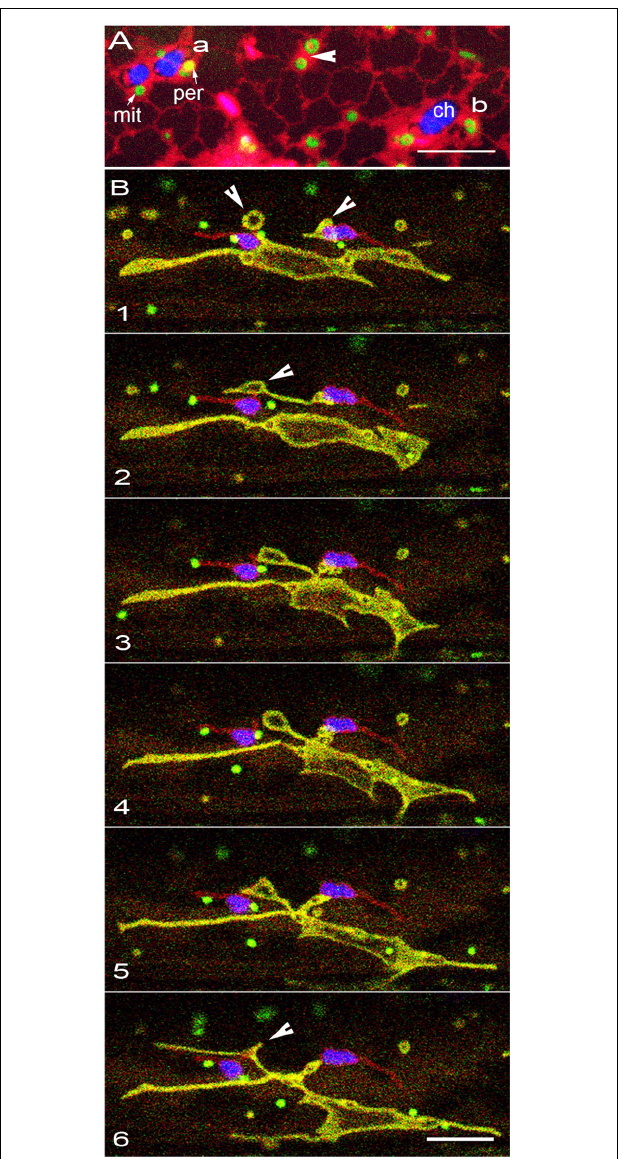
FIGURE 5 | Changes in ER membranes coincide with alterations in the morphology and behavior of other organelles. (A) Representative image of organelles in GPeroxi-YMito-RER triple transgenic plants under hypoxia after 45 min under water. While the ER-tubules (red) have not disappeared completely, chloroplasts (blue – chlorophyll; ch), peroxisomes (yellow – per) and mitochondria (mit – green) become surrounded separately by expanded, thin ER membranes (red). Whereas some regions of the expanded ER may not exhibit entrapped organelles, in other locations such as, “a” three organelles are trapped, “b” shows only a chloroplast and a mitochondrion while an arrowhead indicates two swollen, donut -shaped mitochondria (arrowheads). The phenomenon is reversible. (B) Six sequential snapshots from a time-lapse series ( Supplementary Movie 8 ) illustrate the pleomorphy of expanded dynamic mitochondria while peroxisomes (green) and plastids (red OEM) retain their shapes and motility. While some donut-shaped mitochondria remain independent, other mitochondria indicated by arrowheads (panels 1, 2) fuse over time (arrowhead panel 6) to form a single large mitochondrion. Scale bars = 10 µ